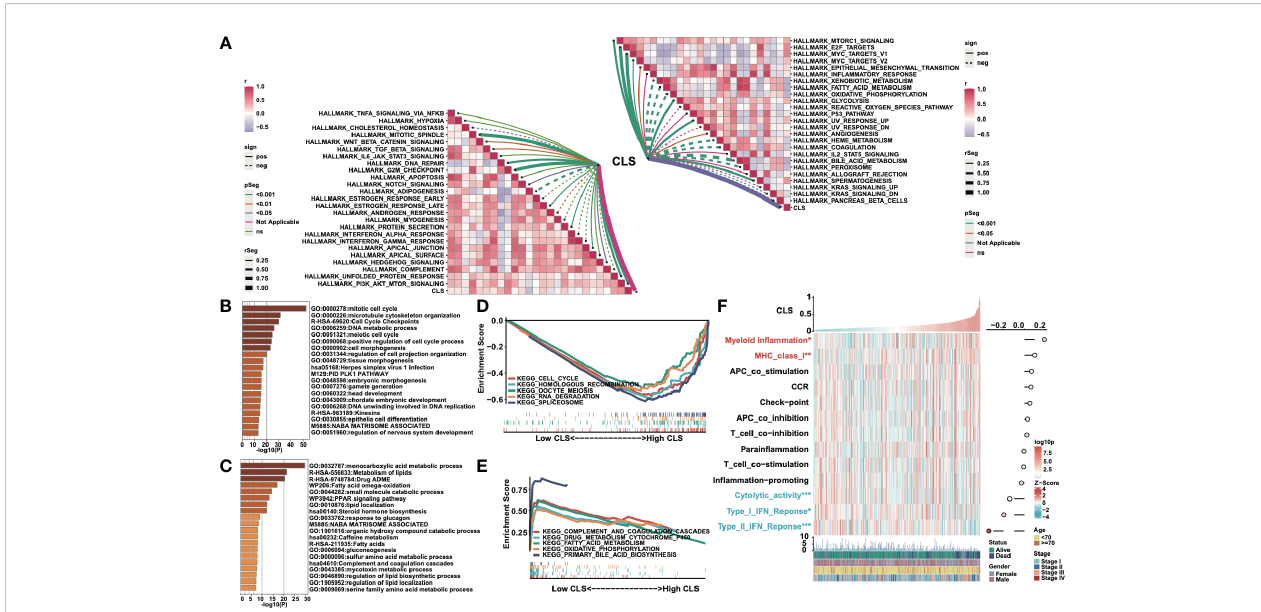
FIGURE 4 Functional analyses of the CLS model. (A) The correlation between CLS and the Hallmark cancer-related pathways. (B) The enriched items in high CLS samples in Metascape. (C) The enriched items in low CLS samples in Metascape. (D) The top fi ve enriched items in high CLS samples by GSEA. (E) The top fi ve enriched items in low CLS samples by GSEA. (F) The expression of the interested pathways in each sample and the correlation between interested pathways and